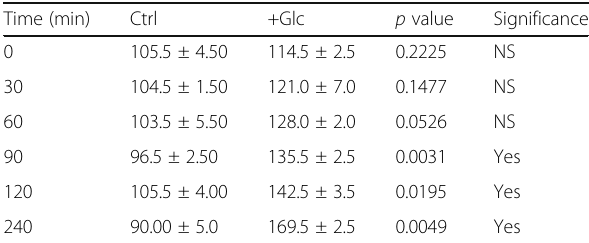
Table 4 Functional analysis of high glucose-regulated up-